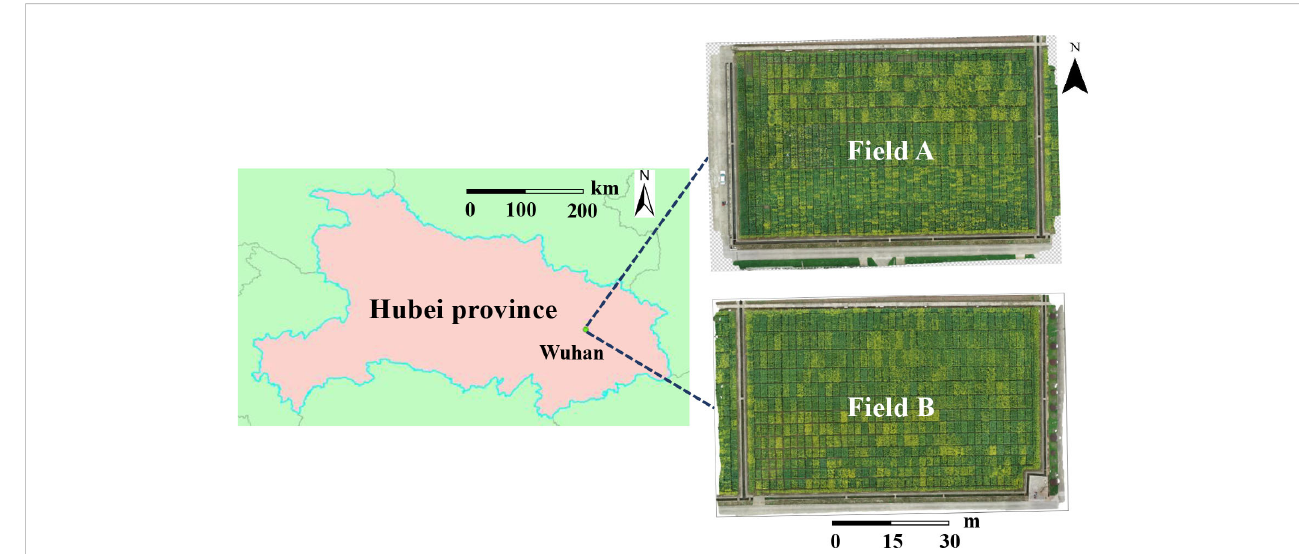
FIGURE 1 The study area (114.51409E, 30.71047N) at Yangluo Base of Oil Crops Research Institute of the Chinese Academy of Agricultural Sciences, Wuhan, China.